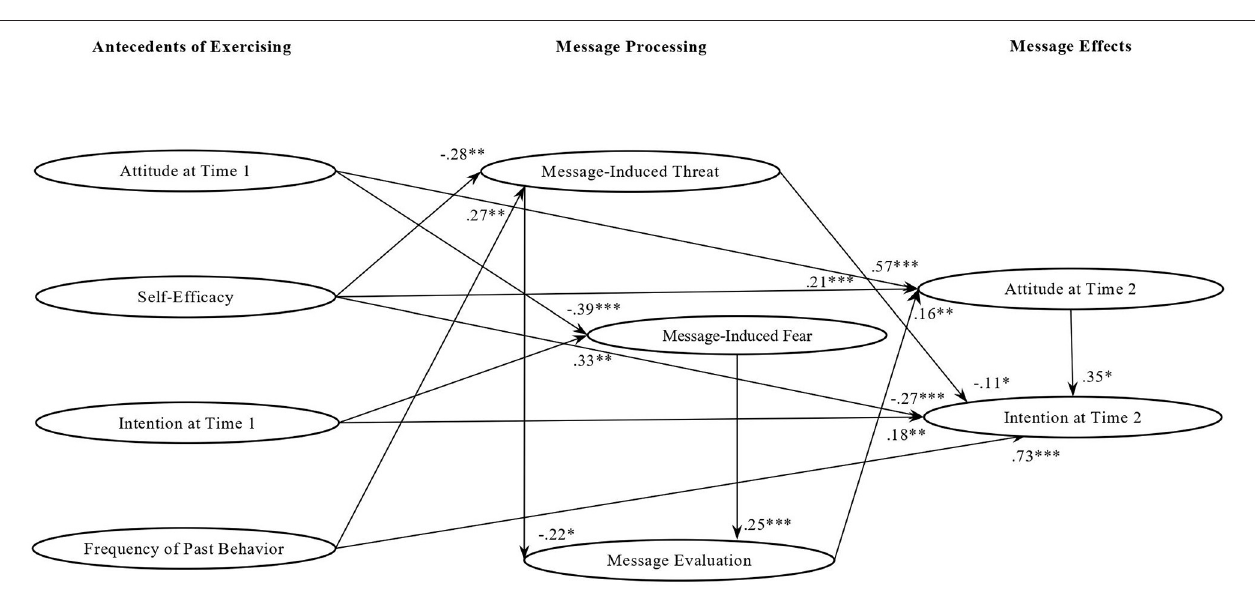
intention at Time 2 ( β = 0.73; p = 0.001) and a higher message- induced fear ( β = 0.33; p = 0.001). Instead, participants with high self-efficacy perceived the loss messages as less threatening ( β = − 0.28; p = 0.05) and had a more positive attitude at Time 2( β = 0.21; p = 0.04) and intention ( β = 0.18; p = 0.02)